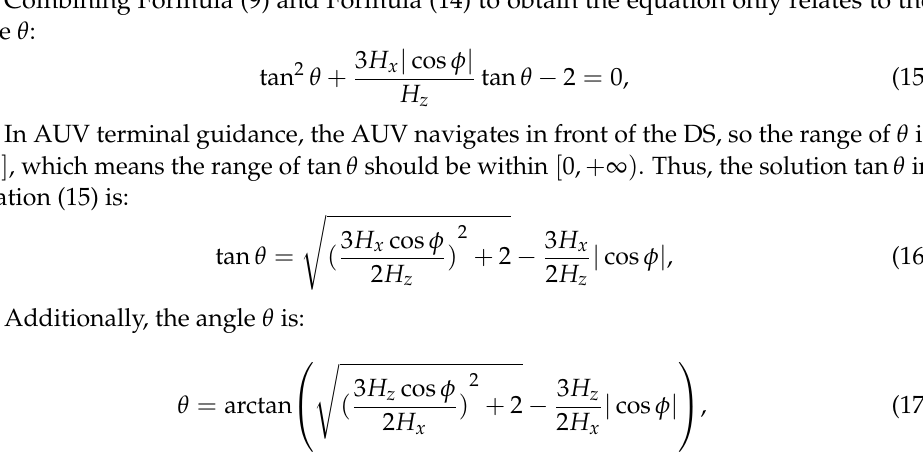
Combining Formula (9) and Formula (14) to obtain the equation only relates to the angle θ :